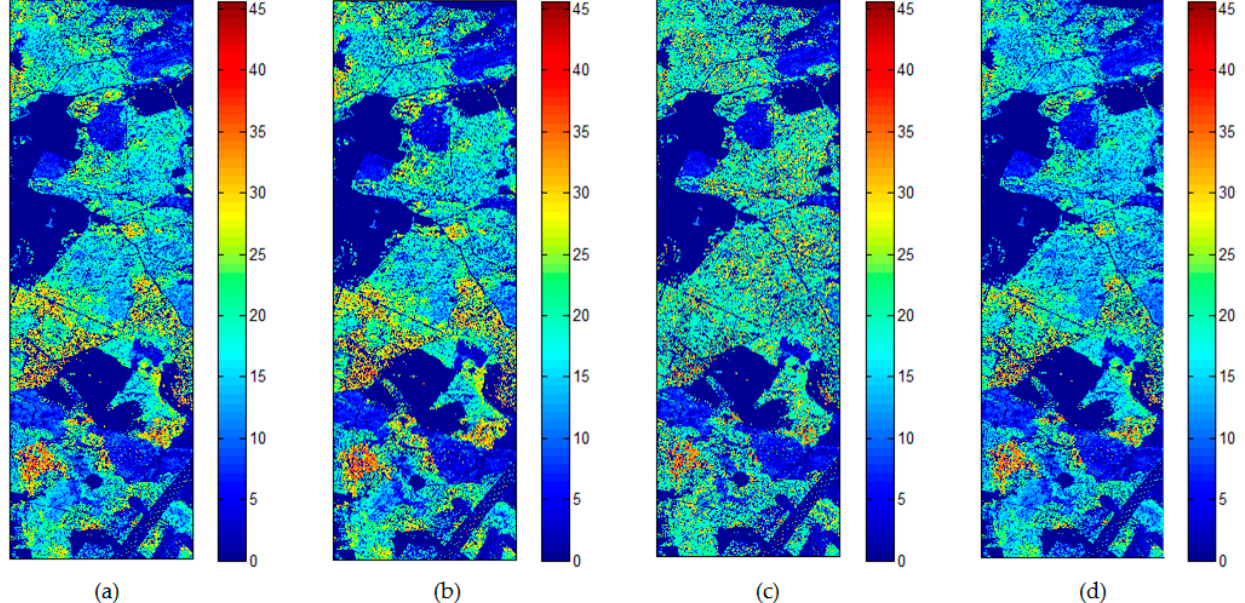
Figure 9. The pixel-wise height estimation results obtained by performing RVoG inversion according to the ( a ) conventional three-stage and ( b ) Wenxue methods as well as the proposed method based on the ( c ) dual PolInSAR data and ( d ) Lidar measurement.